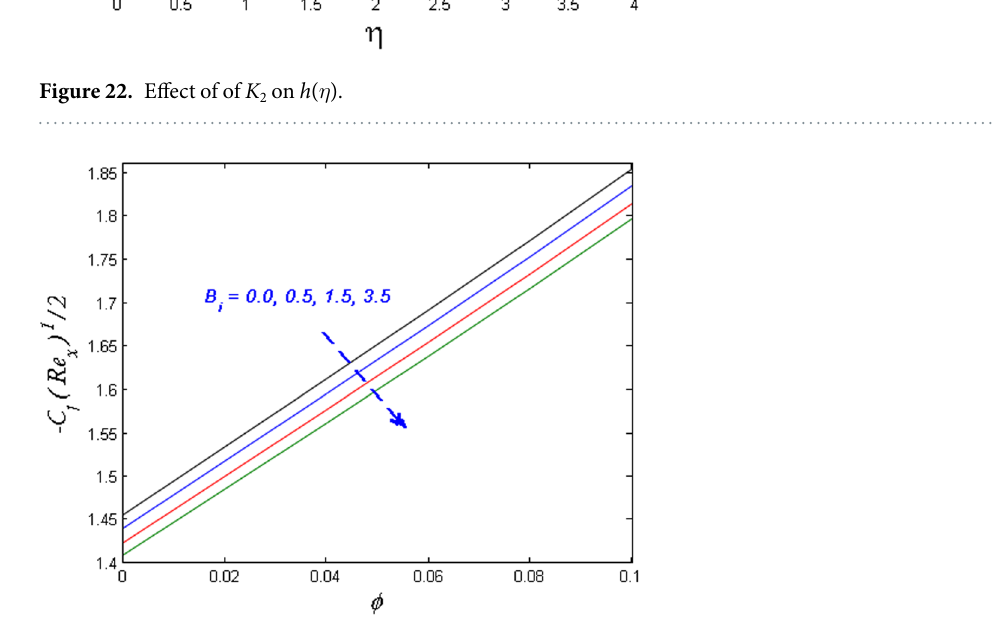
Figure 23. Effects of φ and B i